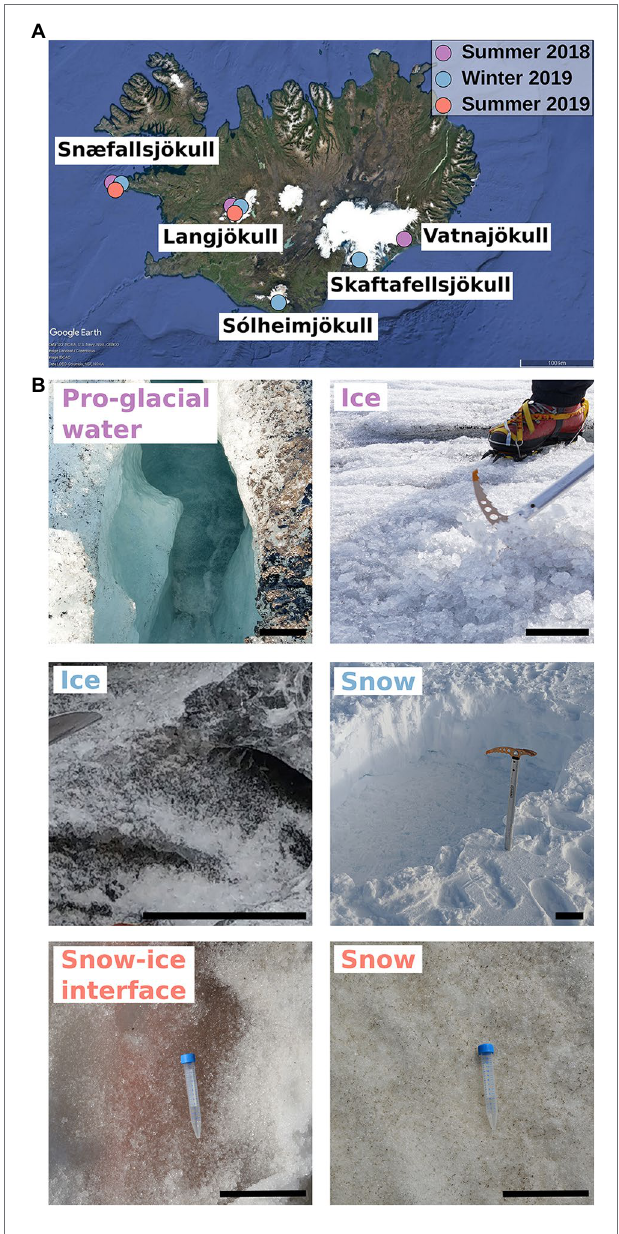
FIGURE 1 | Sampling collection sites and habitats in Iceland. (A) Map of Iceland showing the geographical locations and time of season of the glaciers sampled for this study. (B) Images of representative habitats collected in the different seasons (colors; ice summer 2018 © J. Perez, snow winter 2018 © C. Trivedi, snow–ice interface, snow summer 2019 © J. Bradley, pro-glacial water summer 2018, ice winter 2019 © M. Winkel). The scale bar on all photographs represents 12